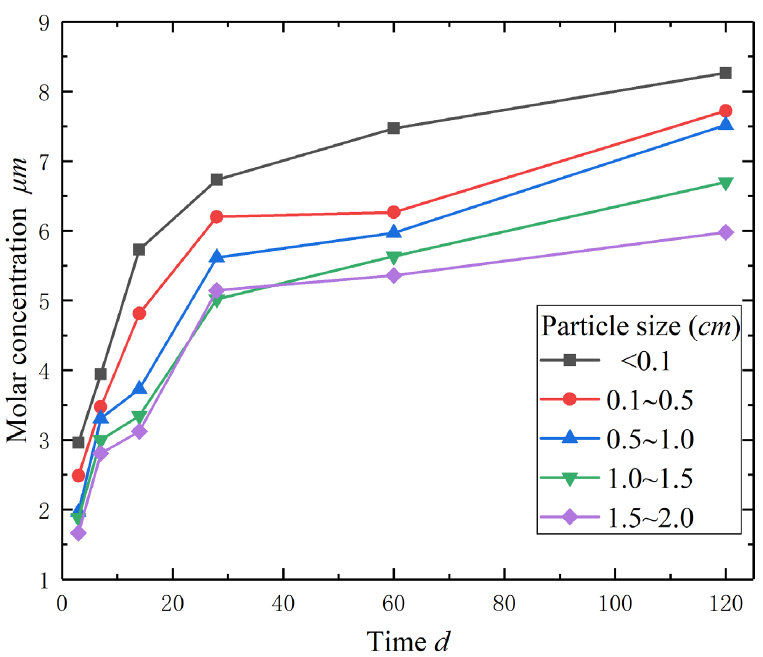
Figure 9. Curves demonstrating the amount of Pb 2+ leaching versus particles sizes.